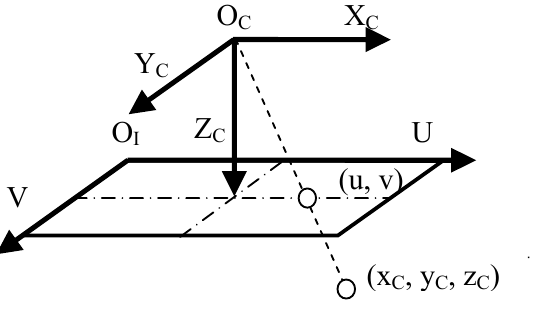
Figure 4. Illustration of a depth image within both the camera coordinate and image coordinate